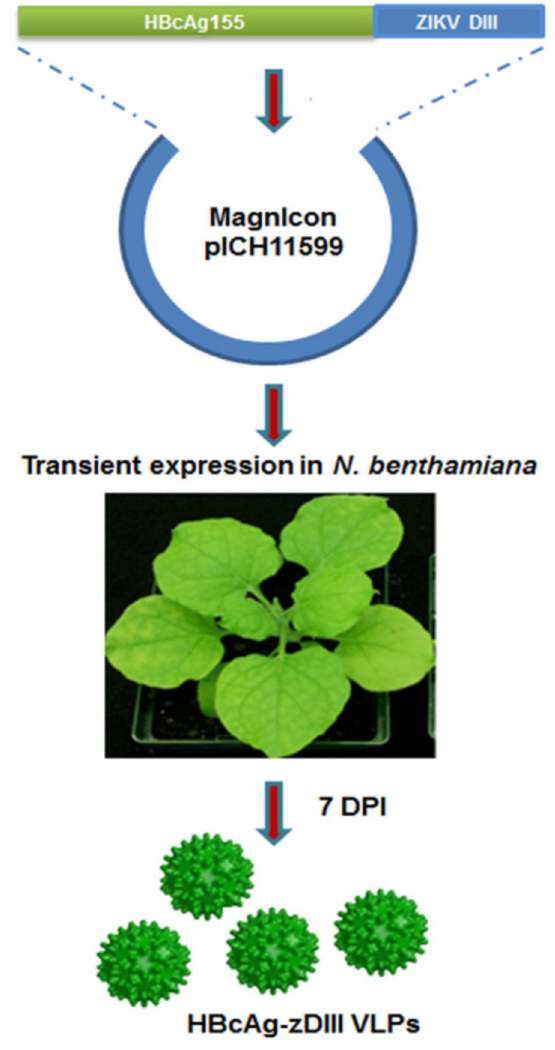
Figure 3. Use of the MagnICON vector for expressing HBcAg-zDIII protein in N. benthamiana . The zDIII coding sequence was genetically fused to the 3 (cid:48) end of the HBcAg gene (amino acid 1–155) and then cloned into the MagnICON-based plant expression vector pICH11599. This construct was transformed into Agrobacterium tumefaciens which was infiltrated into leaves of N. benthamiana to enable transient expression. At 7 days post-inoculation, the leaves were harvested to isolate the HBcAg-zDIII fusion protein. (Adapted from Yang et al., 2017